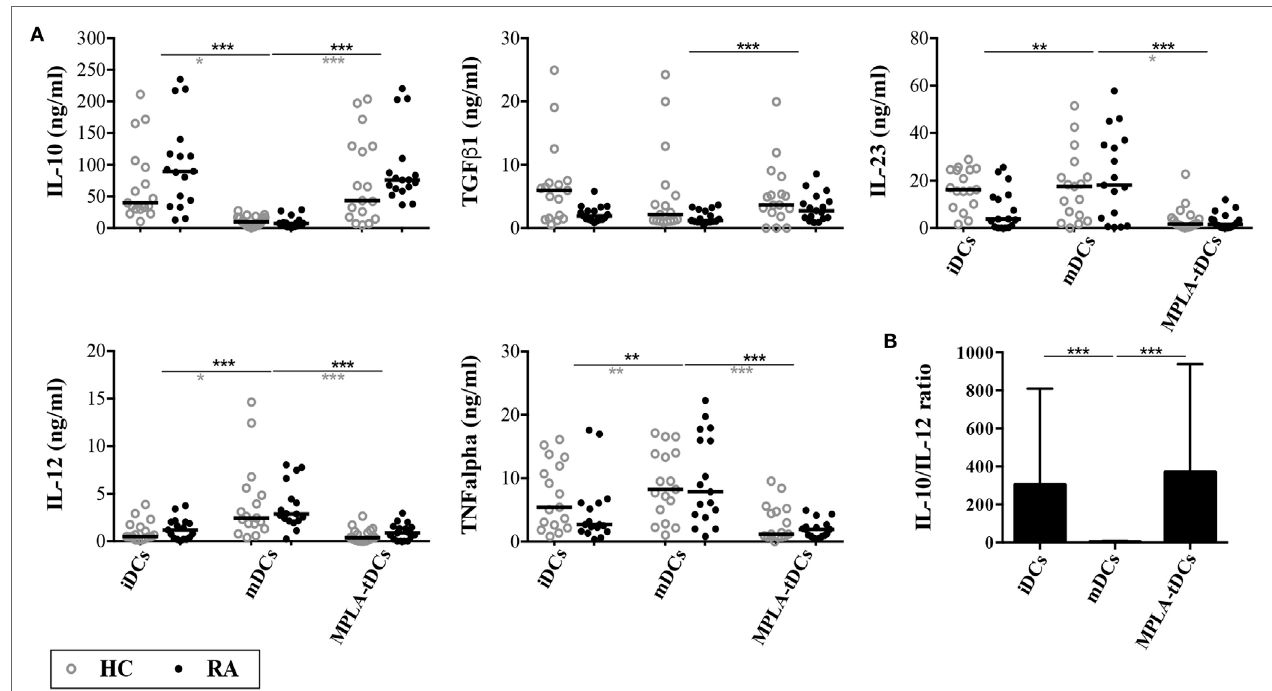
FigUre 2 | MPla-tDcs from rheumatoid arthritis patients exhibit an anti-inflammatory cytokine profile . Monocyte-derived DC (moDC) subsets from rheumatoid arthritis (RA) patients ( black closed symbols ) and healthy control subjects (HC; gray open symbols ) were cultured with CD40L-transfected NIH3T3 cells at 1:1 ratio for 24 h. (a) Concentrations of IL-10, IL-12, IL-23, TNF- α , and active TGF- β 1 were determined in culture supernatants of moDCs by ELISA. (B) Bar chart with values of IL-10/IL-12 ratio of different moDC subsets from RA patients. Dot plots show all data points and horizontal lines indicate median values. Statistical differences were calculated using Kruskal–Wallis test (comparison of HC and RA) or Friedman test (comparison of DC types) and Dunn’s multiple comparison post test (* P < 0.05; ** P < 0.01; *** P <